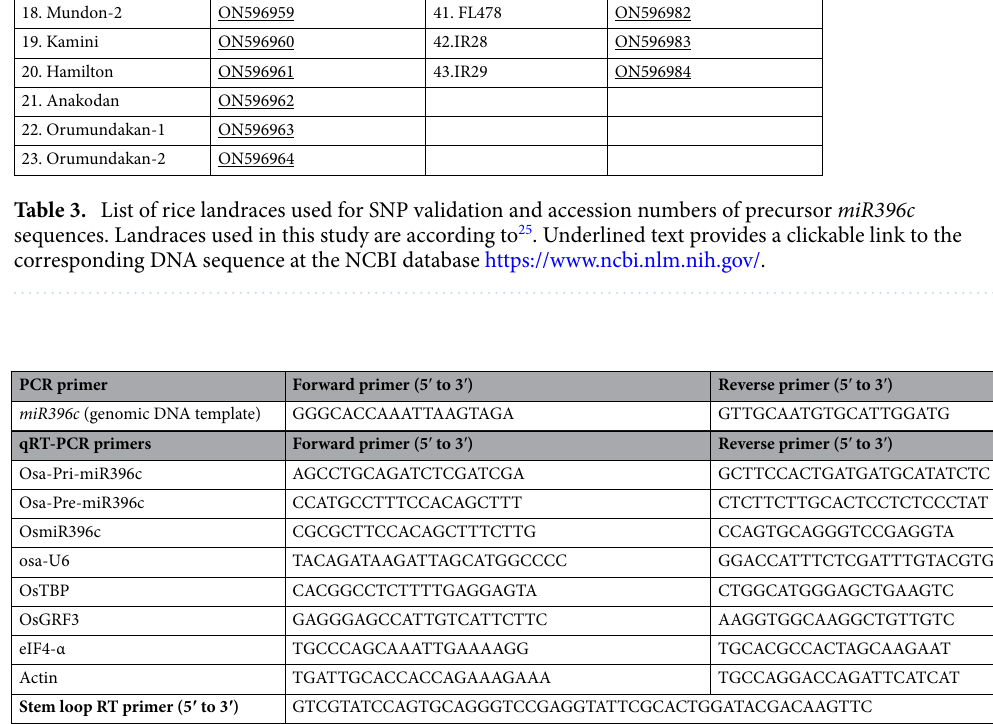
Table 4. Primers used for amplifying miR396c from Oryza species and qRT-PCR.